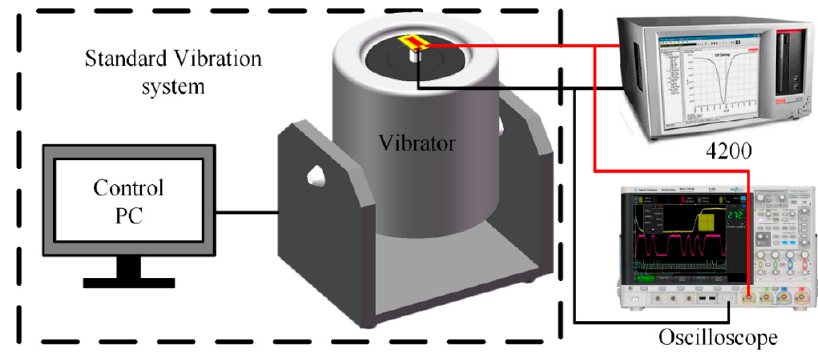
Figure 6. Testing system of acceleration sensor.